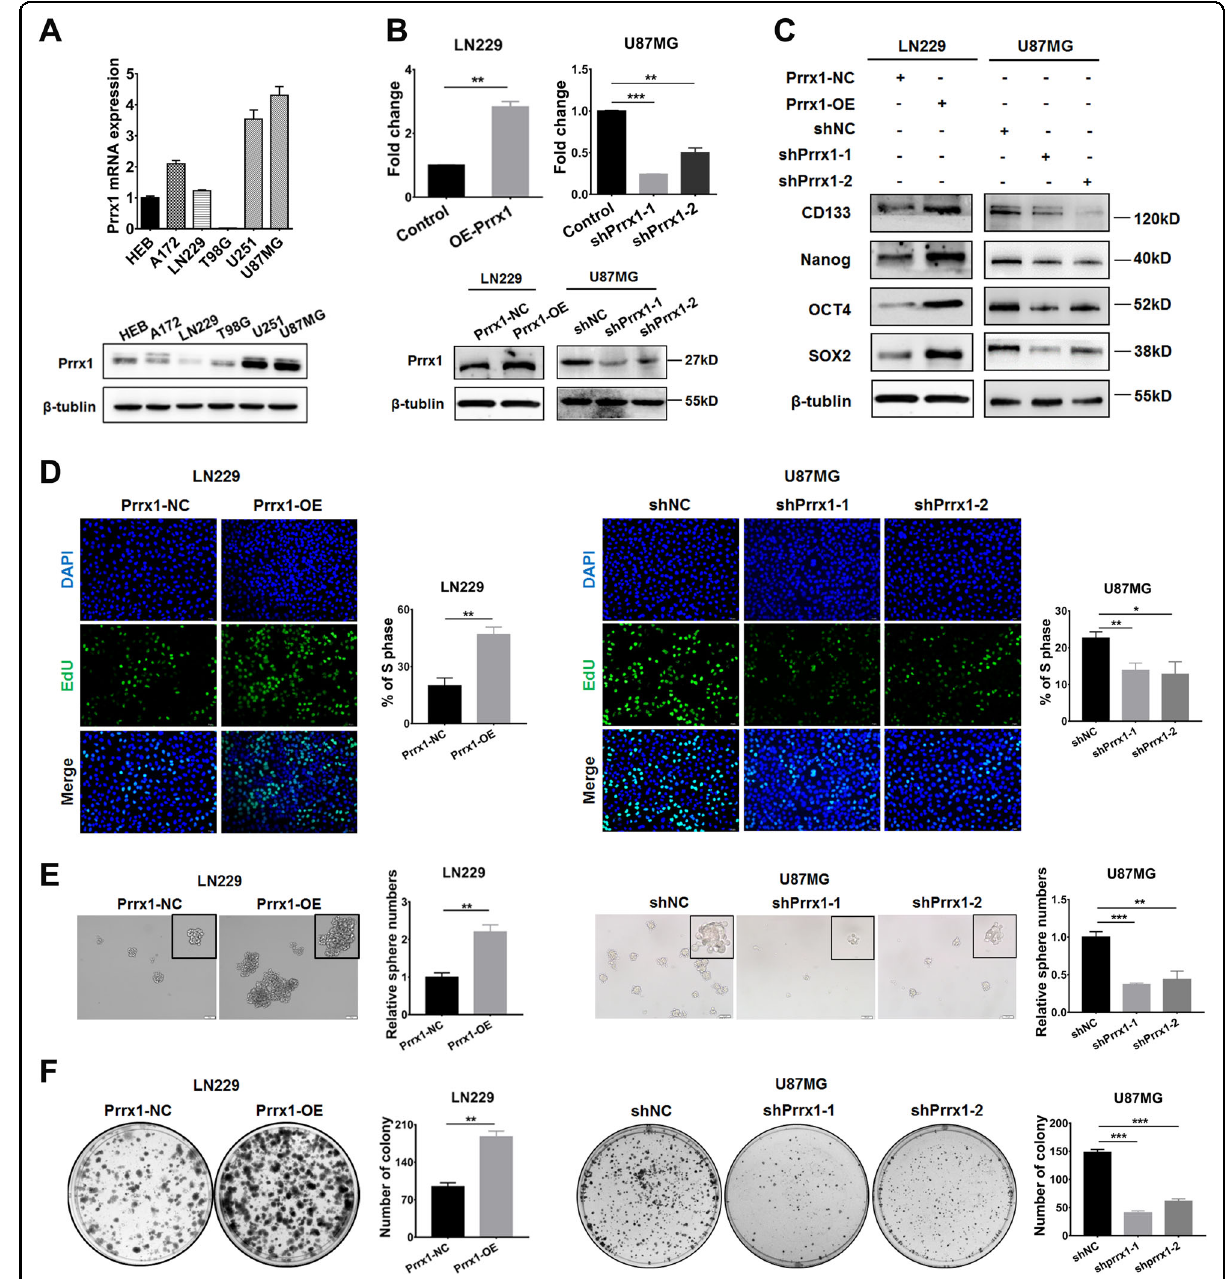
Fig. 2 Prrx1 potentiates stem-cell-like properties acquisition in NSTCs. A Expression of Prrx1 mRNA and protein was detected in HEB and fi ve different glioma cell lines. Each bar represented the mean ± SD ( n ≥ 3). B Western blot and RT-qPCR assay were used to verify the successful construction of Prrx1 overexpression and knockdown glioma cells. C Western blot shows the expression of GSC markers in Prrx1 overexpression and knockdown glioma cells. D EdU assay of NSTCs to explore the effect of Prrx1 on cell proliferation. E , F Sphere formation assay ( E ) and colony formation assay ( F ) of NSTCs to explore the effect of Prrx1 on cell stemness acquisition. Scale bar represents 50 μ m. * P < 0.05, ** P <